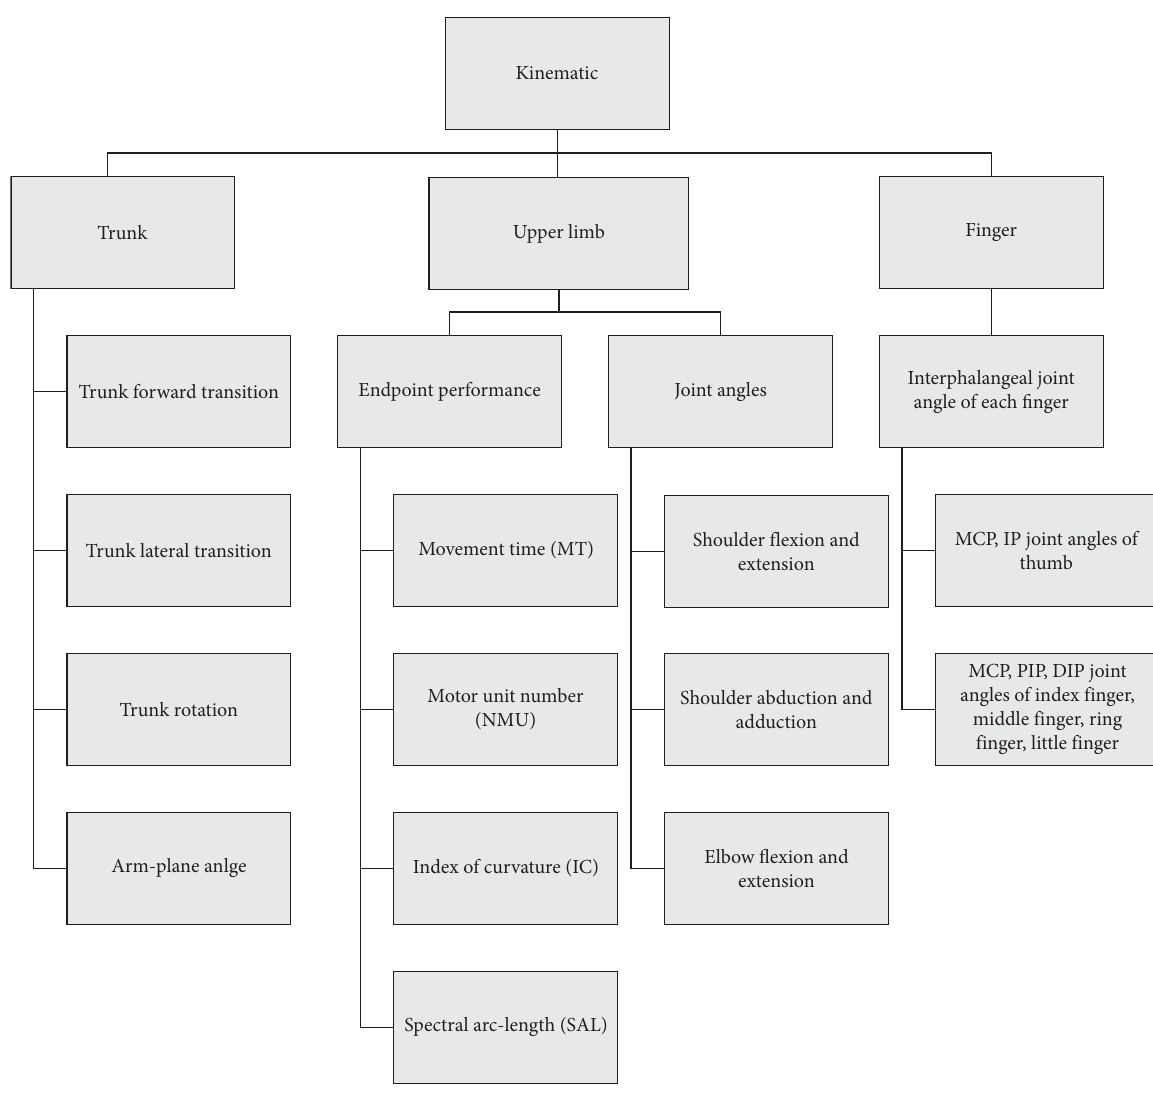
F IGURE 5: Kinematic